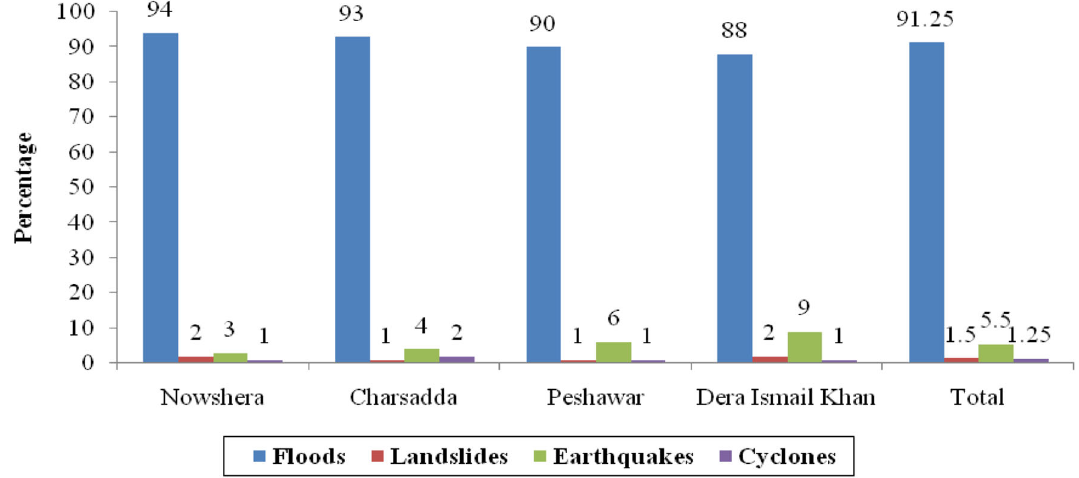
Fig. 2 Floods and other natural hazard-induced disasters experienced by Khyber Pakhtunkhwa’s schools,